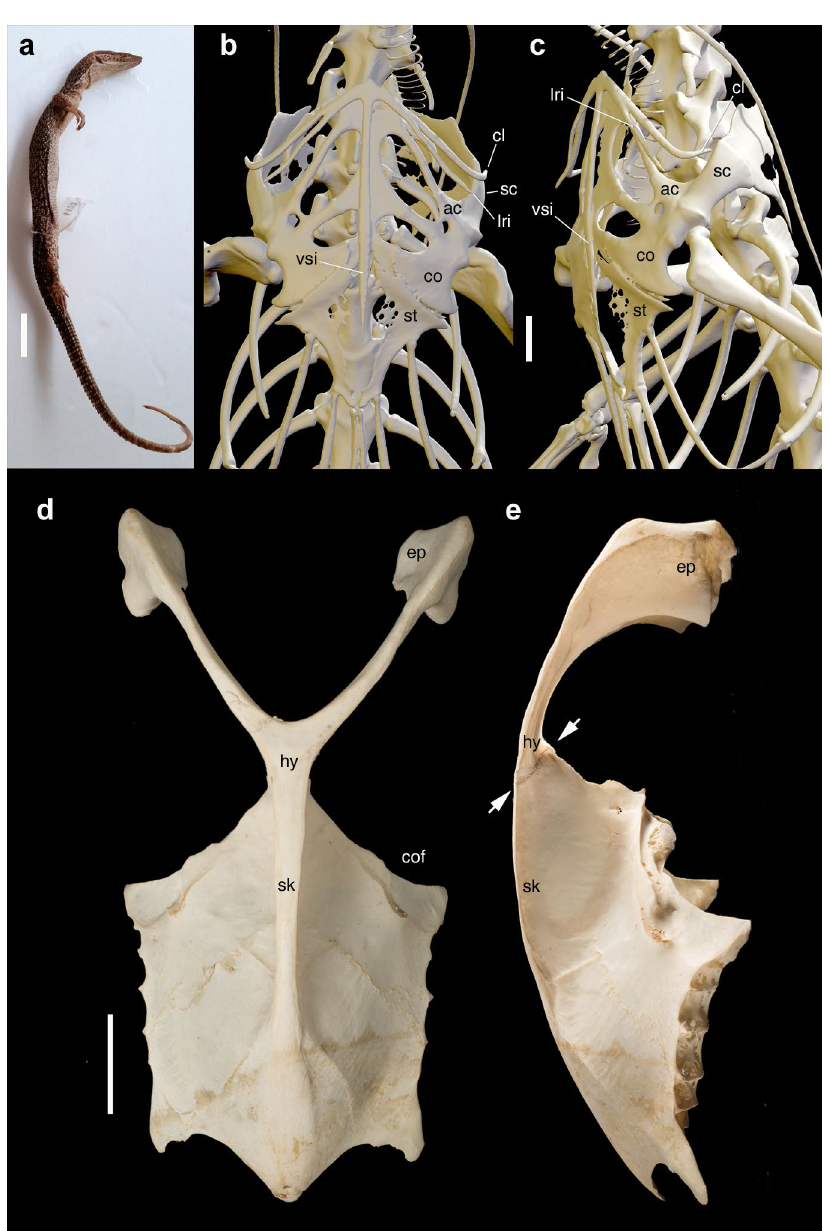
Figure 5. The interclavicle-sternum complex in reptiles and birds. ( a–c ) Varanus storri BE-RBINS-VER-10900. ( a ) The specimen subjected to µCT scanning. ( b,c ) close-up of the digitally reconstructed pectoral complex in ventral view ( b ) and oblique lateroventral view ( c ). Note the positions of clavicle and interclavicle lateral ramus relative to the acromial region, and the visceral overlap of the sternum relative to the posterior end of the interclavicle. ( d,e ) sterno-furcular complex of Pelecanus crispus BE-RBINS-VER-83834 in ventral view ( d ) and lateral view ( e ). Arrows in ( e ) mark the dorsoventral extent of the hypocleideum-sternal articular surface. Note the visceral overlap of the sternum relative to the hypocleideum. ac acromion, cl clavicle, co coracoid, cof coracoid facet, ep epicleideum, hy hypocleideum, lri lateral ramus of interclavicle, sc scapula, sk sternal keel, st sternum, vsi ventral (parasternal) ramus of interclavicle. Scale bars: 20 mm ( a ), 2 mm ( b,c ), 30 mm ( d,e ). Photos in ( a,d,e ) by T. Hubin. Visualization in ( b,c ) performed by J. Brecko using Dragonfly vers. 4.0 for Windows (Object Research Systems Inc., Montreal, Canada, 2020: http:// www. theob jects. com/ drago